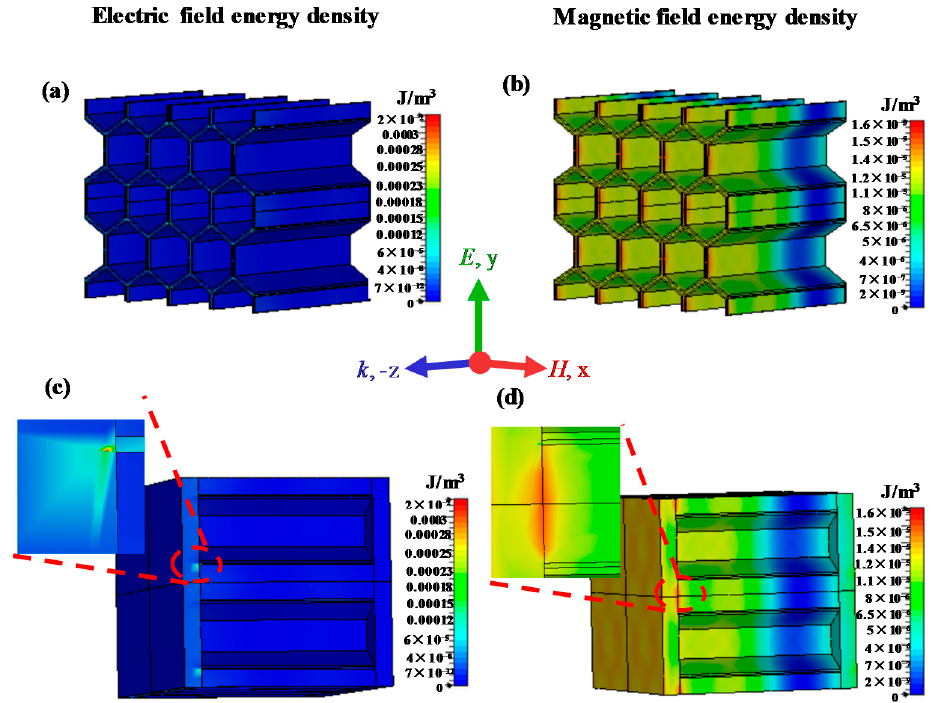
Figure 9. Simulated distributions of electric field energy density (left) and magnetic field energy density (right) of microwave-absorbing structures: ( a , b ) honeycomb core; ( c , d ) honeycomb sandwich structure.